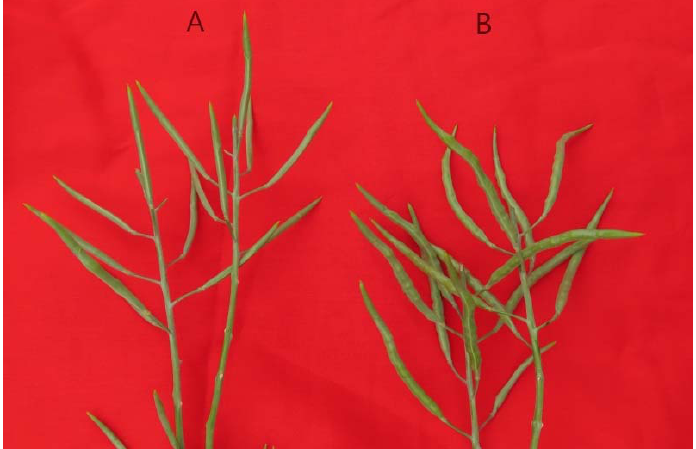
Figure 8. PCR amplification of nine pairs of SSR primers in 18 ‐ 512 sister lines (18 ‐ 512, 18 ‐ 2169 ‐ 1, 18 ‐ 2169 ‐ 2, 18 ‐ 2169 ‐ 3, 18 ‐ 2170 ‐ 1, 18 ‐ 2170 ‐ 2, 18 ‐ 2170 ‐ 3 from left to right). M represents the DNA Marker 500; numbers 1 to 18 represent SSR primers BoE188, BoE607, BoE162, BoE966, BoE222, BoE718, BoE002, BoE450, BoE882, BoE699, BoE379, BoE761, BoE723, BoE209, BoE875, BoE134, BoE734, BoE051. 2.5. Development of the Class I S ‐ Haplotype Primer Identification System The sequences of S7/S33 (C06: 32,096,418–32,097,017) and S33/S45(C06: 32,097,589– 32,097,017) in TO1000 (http://plants.ensembl.org/Brassica_oleracea/Info/Index, accessed on 25 June 2021) were compared to design specific primers. The length of amplified bands from each S ‐ haplotype was predicted (Table 2). Newly developed primers were tested with known S ‐ haplotype materials (Figure 9). According to the results, we found that pri ‐ mers TS33 ‐ F/TS7 ‐ F/TS ‐ R and TF33 ‐ F/TF45 ‐ F/TS ‐ R were the optimal primer sets to distin ‐ guish S7/S33 and S33/S45, respectively. The two sets of codominant primers could be used to directly distinguish the three S ‐ haplotypes of B. oleracea by one ‐ step Tri ‐ Primer ‐ PCR without sequencing, which is a more convenient and rapid method for the differentiation of the S ‐ haplotypes in B. oleracea .